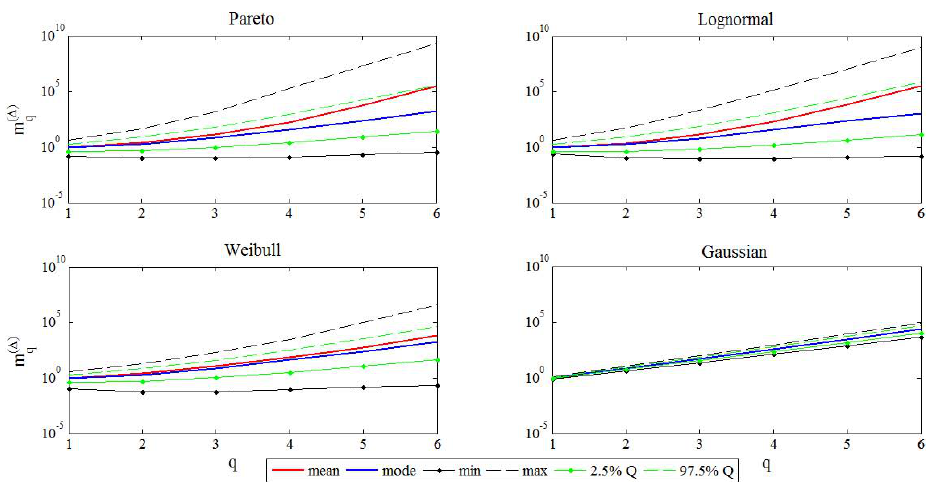
Fig. 8. Semi-logarithmic plots of the prediction intervals of the sample moments versus the order q for various marginal probability distribu- tions, assuming 1 = 1.